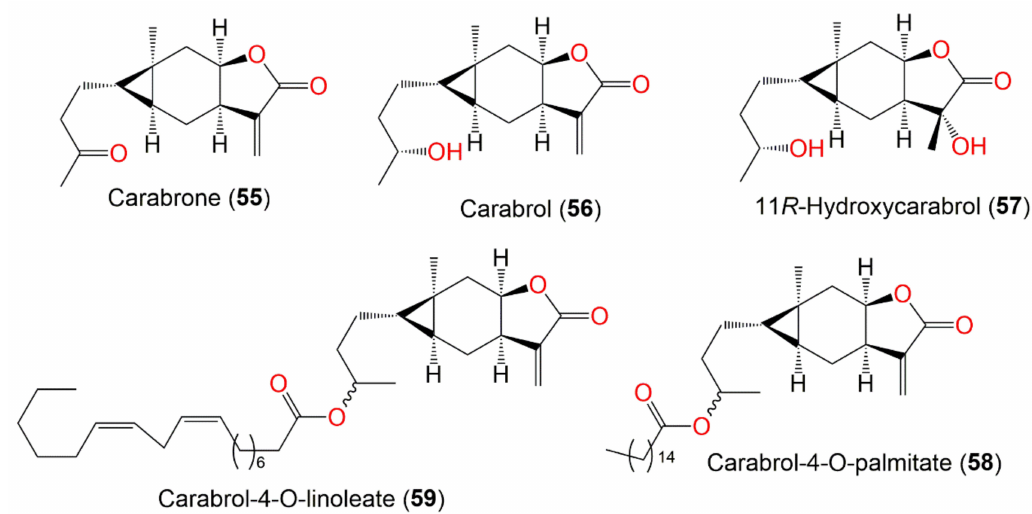
Figure 9. Sesquiterpenes with cyclopropane ring ( 55 – 58 ) reported from C. abrotanoides . A new dimeric sesquiterpene, dicarabrol ( 60 ), in addition to 31 , 48 , and 56 were pu- rified from C. abrotanoides whole plant EtOAc fraction (Figure 10). Compound 60 was 2R,3R,4R,6R,7S,10S,11R,12R,14R,15R,20S,23S,28S-configured and featured two sesquiter- pene lactone units connecting through a cyclopentane ring. These metabolites revealed potent in vitro cytotoxic capacity versus the K562, MCF-7, Hela, DU145, U937, H1975, SGC-7901, A549, MOLT4, and HL60 cell lines (IC 50 ranged from 0.10 to 46.7 µ M), compared with taxol (IC 50 s 2.1–9.8 µ M), whereas 60 had powerful effectiveness than taxol versus all cell lines. Moreover, compounds 31 , 48 , and 60 had antiviral potential versus H1N1 (IC 50 s 10.8–45.5 µ M) and H3N2 (IC 50 s 11.6–47.3 µ M) compared to osehamivir (IC 50 s 0.025 and 0.015 µ M, respectively) in the CPE inhibition assay and marked antimycobacterial capacity (MICs 3.7, 6.0, and 7.6 µ M, respectively) versus M. tuberculosis , relative to INH (isoniazid, MIC 2.0 µ M) in the GFPMA (green fluorescent protein microplate assay. All compounds possessed no COX-1 and COX-2 inhibition